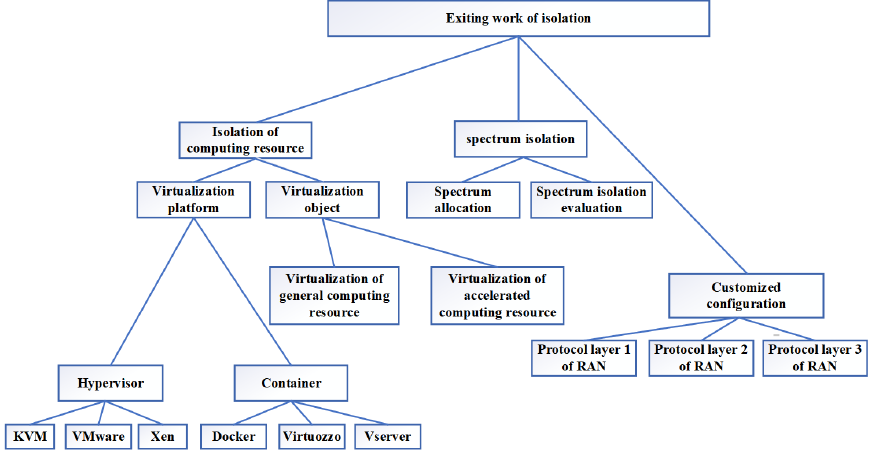
Figure 1. Existing work of NPN isolation.